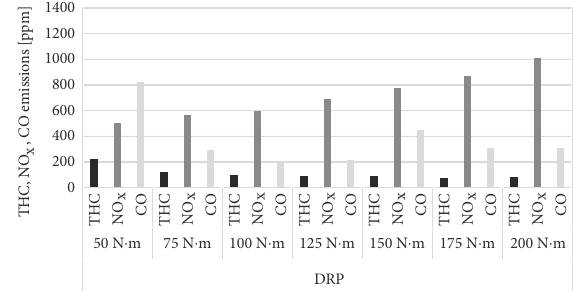
Figure 20. Emission of CO 2 and O 2 for DRP sample with operating parameters of engine 1500 rpm